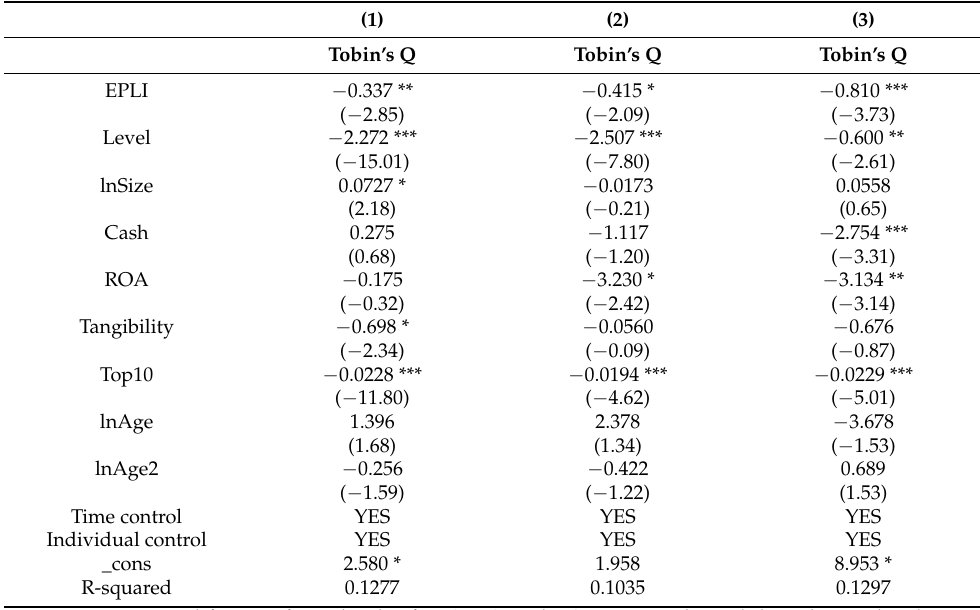
Table 10. Heterogeneity of marketization